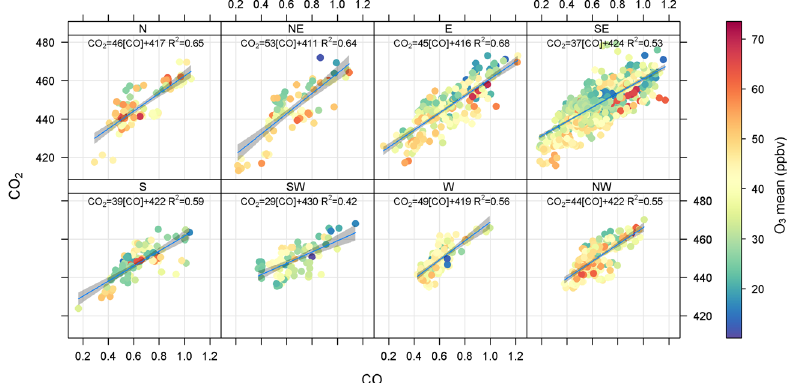
Fig. 5 Estimated CO 2 emissions and their relationship to ozone (O 3 ) concentrations. Scatter plots showing how the relationship between CO 2 and CO affected O 3 concentrations (colour-coded by intensity) in each wind quadrant. The slope obtained from the linear regression can be interpreted as a proxy for CO 2 emissions, lower slope values indicating lower CO 2 emissions (usually from low-ef fi ciency combustion processes, such as burning biomass in the open fi eld) and higher values indicating higher CO 2 emissions (from combustion processes that are more ef fi cient, such as the burning of sugarcane bagasse to generate